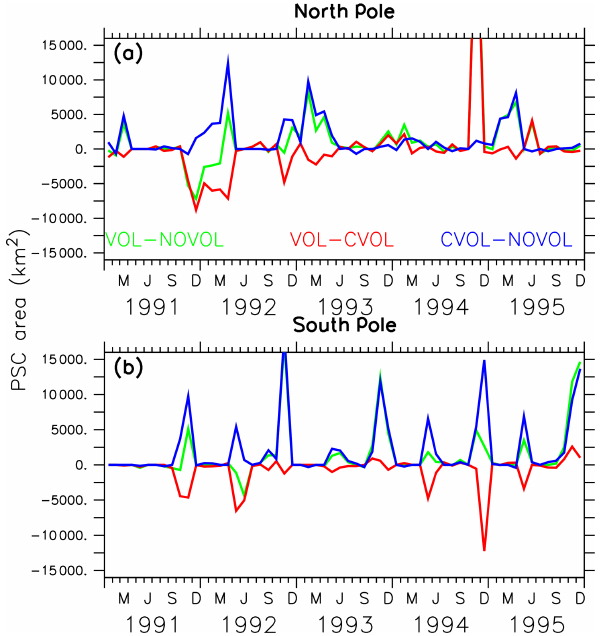
Figure 13. Differences in polar stratospheric cloud (PSC)-covered area (km 2 ) at the North Pole (60–90 ◦ N) (a) and South Pole (60– 90 ◦ S) (b) for the combined effect (green), the heating effect (red), and the chemical effect (blue).